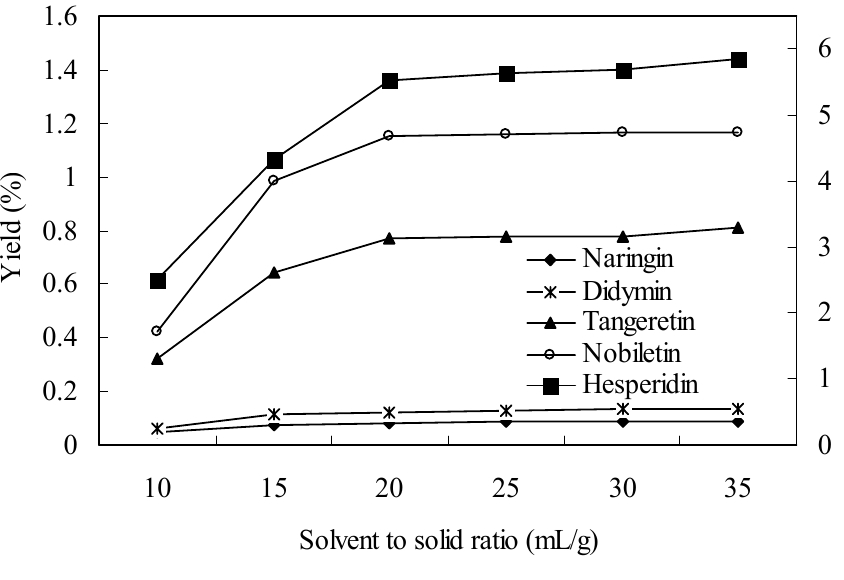
Figure 2. Effect of solvent to solid ratio on the yield of flavonoids (other conditions were fixed at time = 60 min, temperature = 30 °C, power = 250